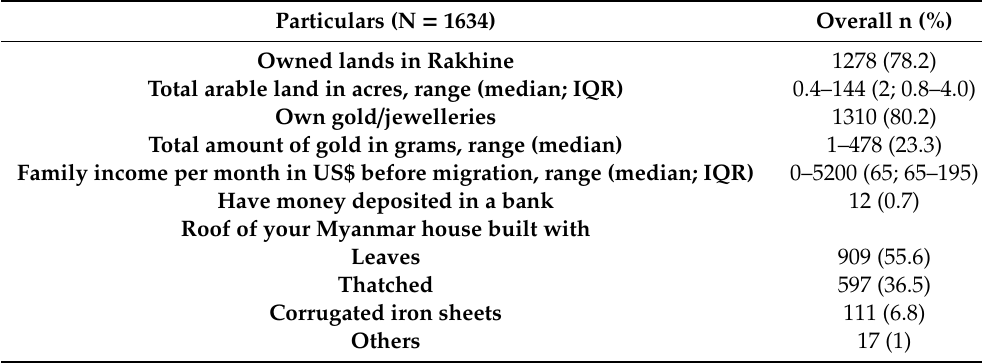
Table 2. Economic background of primary respondents among Rohingya